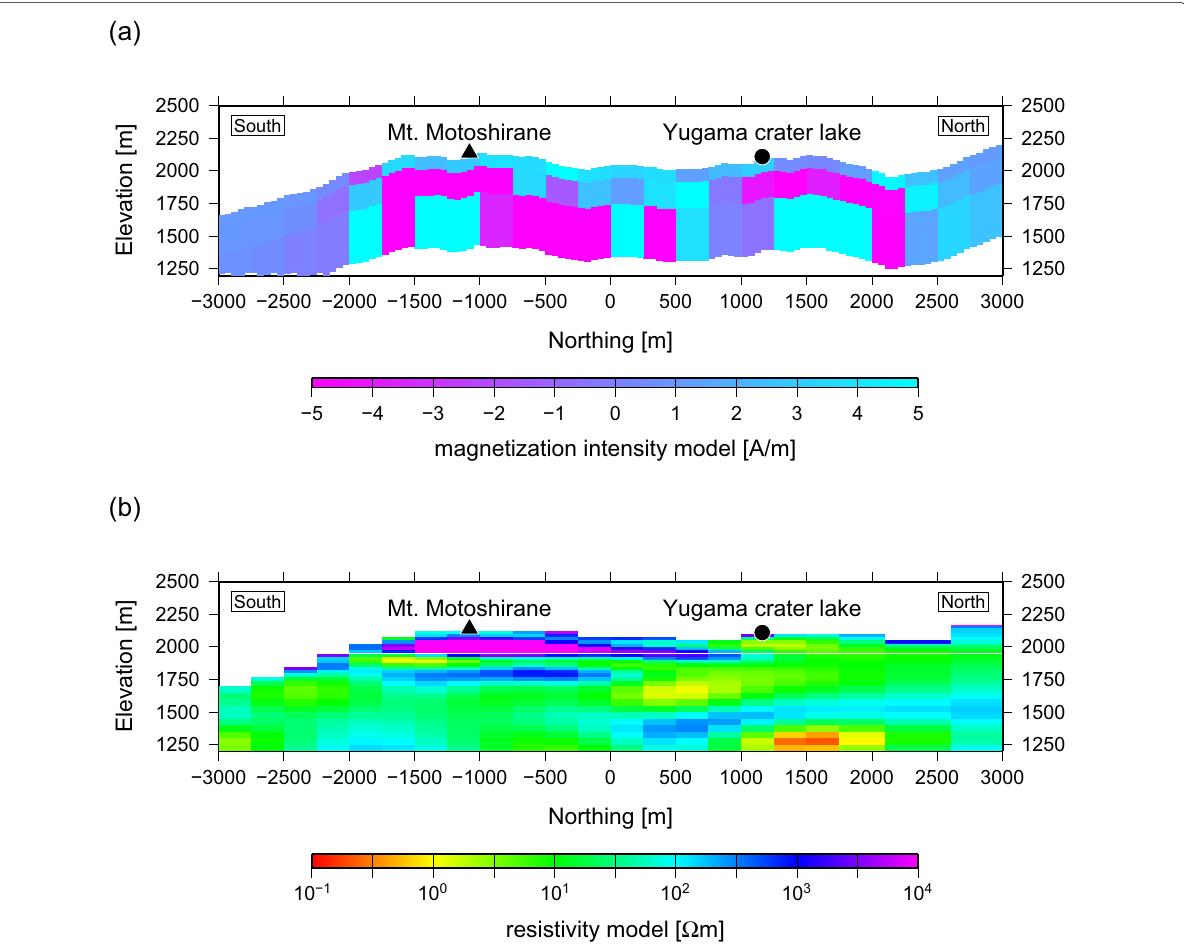
Fig. 4 a Vertical profile of the magnetization intensity model along a dashed line in Fig. 3, through Mt. Motoshirane (closed triangle) and Yugama crater lake of Mt. Shirane (closed circle). b Vertical profile of the electrical resistivity model by Matsunaga et al. (2020) on the same line of